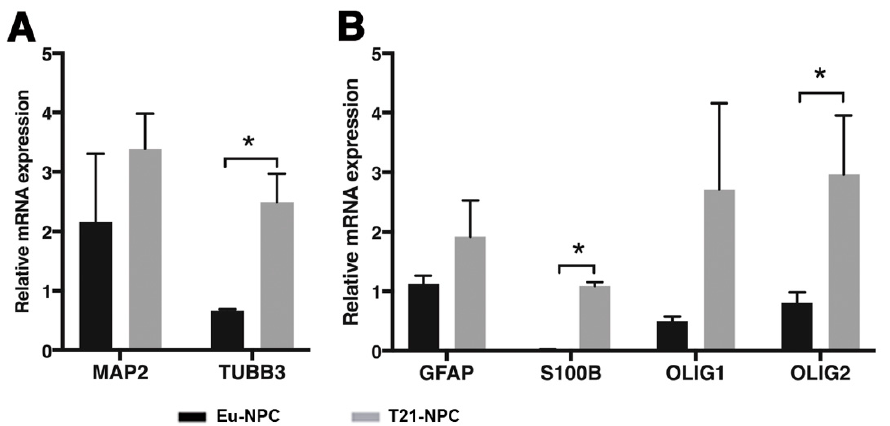
Figure 8. Quantitative qRT-PCR analysis of neuronal, astroglial and oligodendroglial markers in NPCs at day 21 of neural induction. ( A ) The differentiated neuronal cell markers, MAP2 and TUBB3 , were analyzed by qRT-PCR in euploid and trisomic NPCs, at day 21 of neural induction. An higher level of TUBB3 expression is observed in T21-NPCs. ( B ) The level of expression of GFAP , S100B , OLIG1 and OLIG2 , was analyzed by qRT-PCR in euploid and trisomic NPCs. mRNA expression is normalized to a reference gene ( ACTIN ). T21-NPC values represent the average of the two trisomic clones used. Results are expressed as mean values ± SEM of at least four independent experiments for each cell line. * p < 0.05.